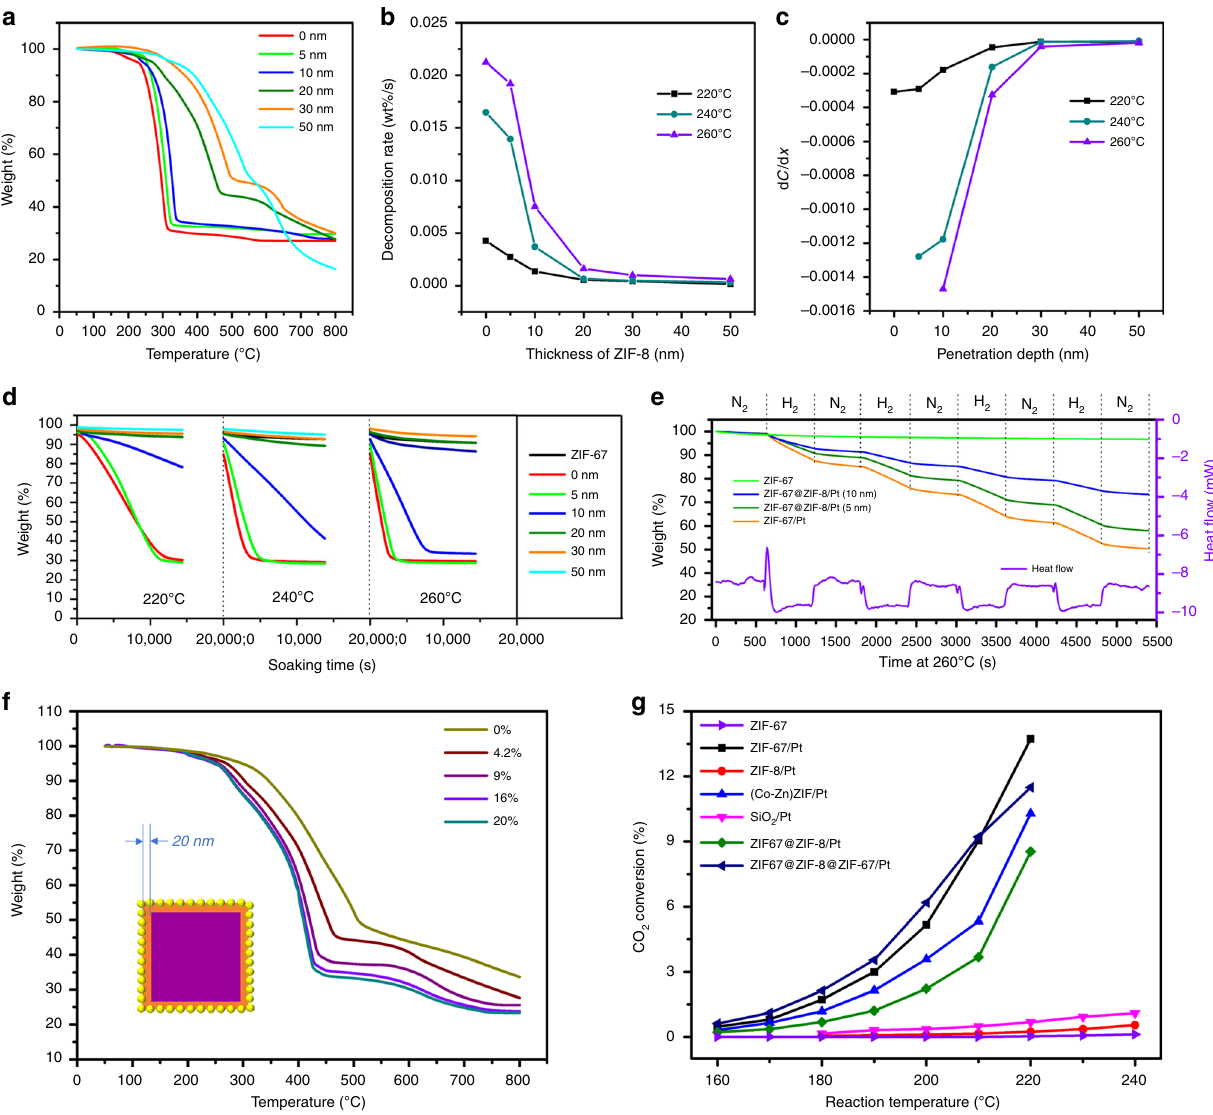
Fig. 9 Hydrogen spillover on different ZIF composite materials. a TGA pro fi les of ZIF-67@ZIF-8/Pt with various thickness of ZIF-8 layer under fl owing H 2 (H 2 % = 4.2% in N 2 ) with a heating rate of 3 °C min − 1 , b the ZIF-8 shell thickness-dependent ZIF-67 decomposition rate, c the penetration depth- dependent H concentration gradient (that is, 1st derivative of decomposition rate of ZIF-67) at three different investigated temperatures, d time evolution of weight loss of various samples at 220 °C, 240 °C and 260 °C for 4 h under fl owing H 2 (H 2 % = 4.2% in N 2 ), e TGA pro fi les of different ZIF composites soaking under fi ve N 2 /H 2 gas cycles, f TGA pro fi les of ZIF-67@ZIF-8/Pt (ZIF-8 shell thickness of 20 nm) under fl owing H 2 with different concentrations, and g catalytic performance of different ZIFs or the composite materials for CO 2 hydrogenation; reaction conditions: gas fl ow rate of 12 mL min − 1 , pressure of 30 bar, and solid sample amount of 0.2